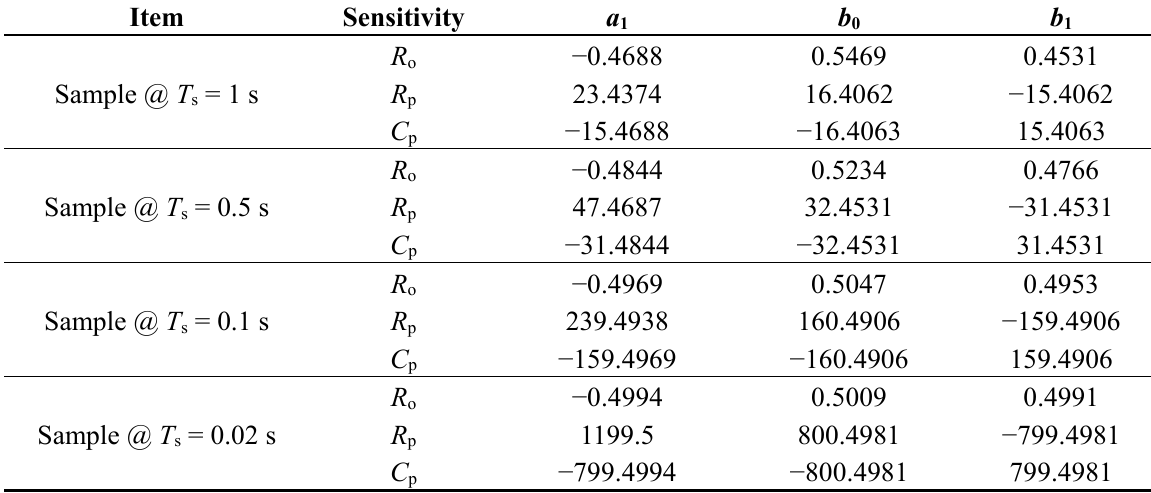
Table 4. Parametric sensitivity analysis of the ARX model at four sample periods ( T s = 1/0.5/0.1/0.02